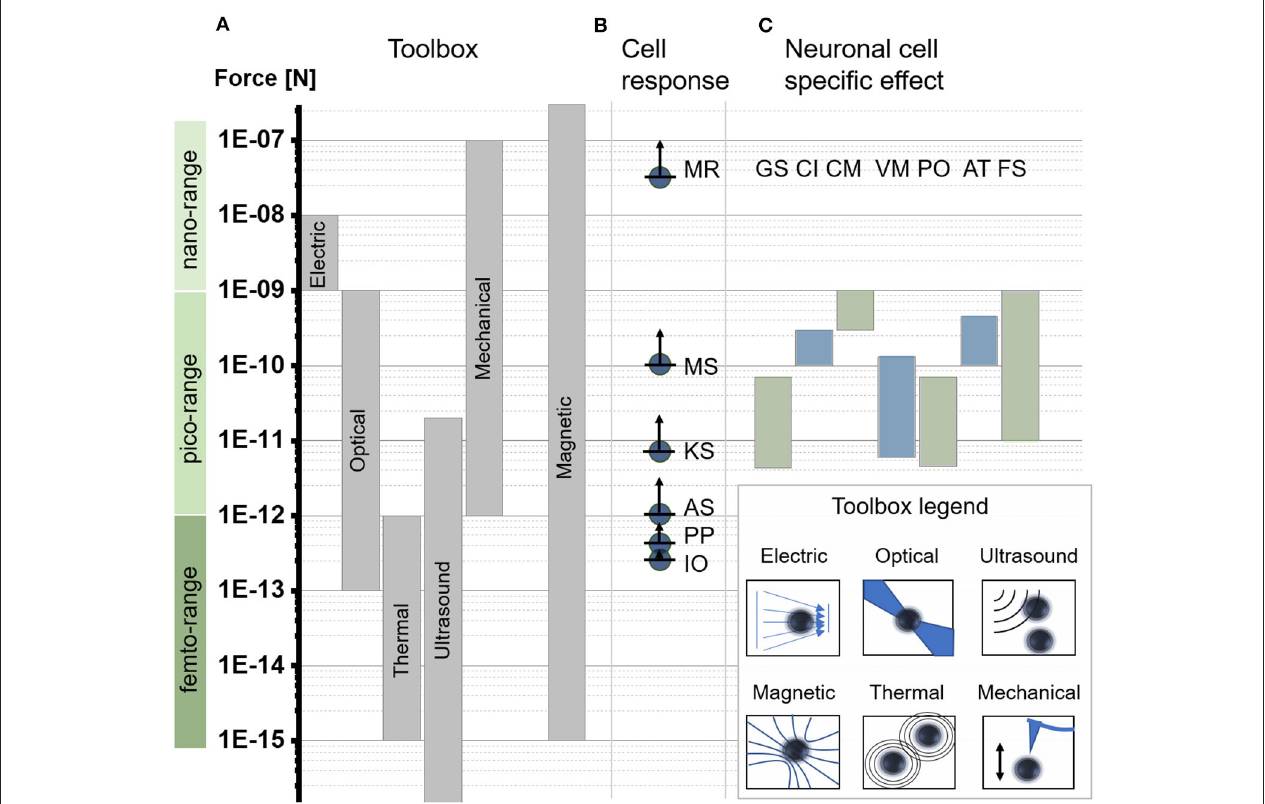
FIGURE 2 | Force scales relevant to subcellular applications. (A) Force-generating toolbox to manipulate subcellular forces. Force direction and amplitude are controlled through physical concepts based on electric field gradients = electric, optical tweezers = optical, acoustic tweezers = ultrasound, magnetic tweezers = magnetic, thermal tweezers = thermal, or mechanical actuation = mechanical. ( Jeney et al., 2004; Neuman and Nagy, 2008; Mosconi et al., 2011). (B) Minimum reported force values required for different cell effects based on computational or experimental models including membrane rupture (MR), ( Almeida and Vaz, 1995) microtubules stretching (MS), (Dogterom and Yurke, 1997; Brangwynne, 2006) kinesin motor stalling (KS), (Svoboda and Block, 1994; Visscher et al., 1999) actin stalling (AS), ( Footer et al., 2007) protein polymerization (PP), (Footer et al., 2007) ion channel opening and thermal fluctuation (IO). (Meister, 2016) (C) Overview of experimentally reported force ranges indicating significant changes in neuronal cell function and morphology induced through a force stimulus. The list highlights general reported mechanical sensitivity for neurons (GS), ( Zablotskii et al., 2016a,b) force mediated calcium induction (CI), (Calabrese et al., 2002; Matthews et al., 2010; Maneshi et al., 2014; Tay et al., 2016a ) force mediated cell migration/displacement (CM), (Kunze et al., 2015) force mediated modulation of vesicle motion (VM), (Kunze et al., 2017) force mediated protein positioning (PO), (Kunze et al., 2015) force mediated axon towing and stretching (AT), (Bray, 1984; Suter and Miller, 2011) and force mediated filopodia/growth cone stretching (FS). ( Franze,